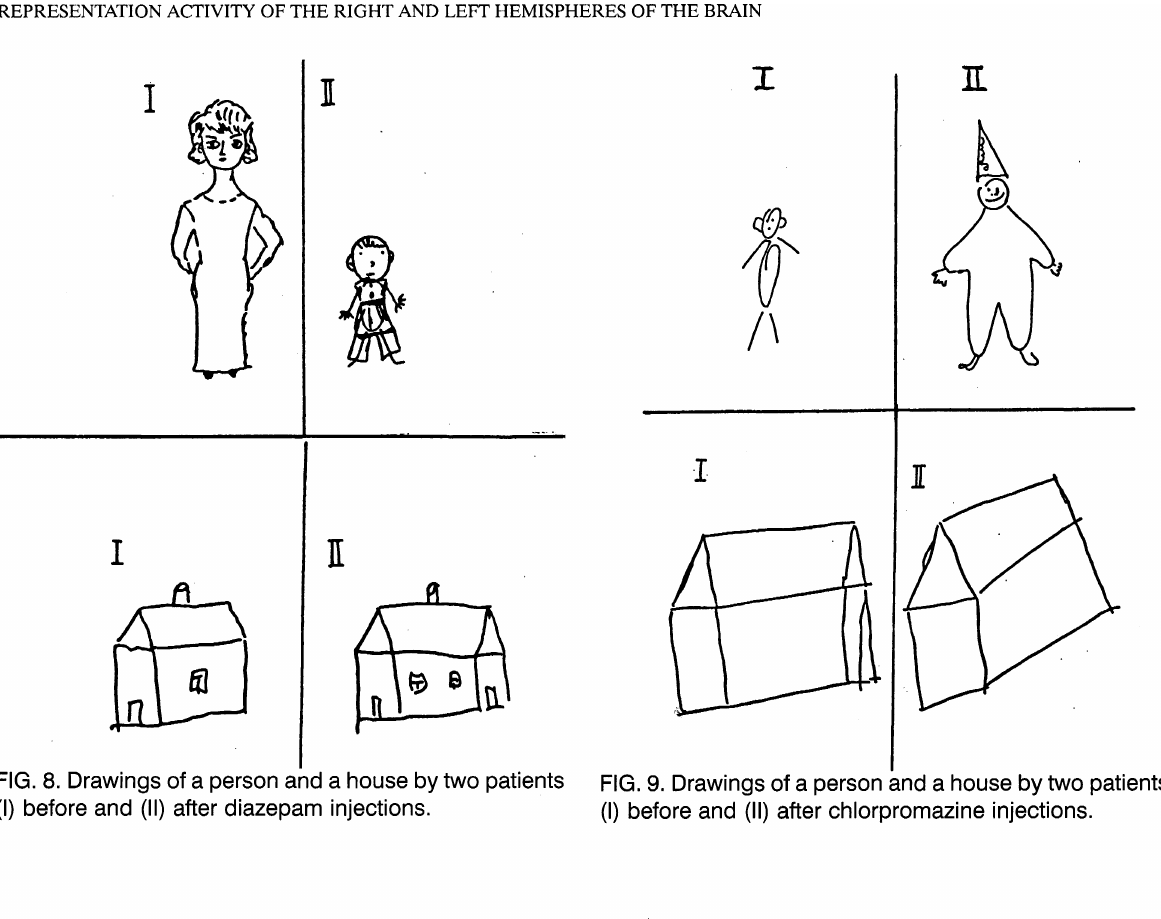
FIG. 8. Drawings of a person and a house by two patients (I) before and (II) after diazepam injections.